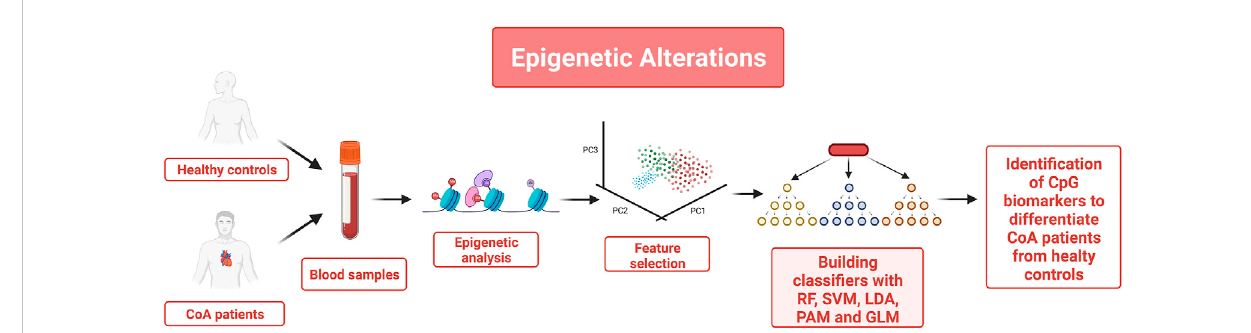
FIGURE 3 Blood samples were utilized to identify epigenetic changes that allow distinguishing healthy controls from patients with coarctation of the aorta (CoA).Cytosinenucleotide(CpG)methylationchangesobtainedfromGenome-wideDNAmethylationanalysiswereselectedasmeanfeatures.Onlythe probes with statistically signi fi cant methylation differences combined with a suf fi ciently high methylation fold change were kept as features and Multivariate approaches such as principal component analysis (PCA) and partial least squares-discriminant analysis (PLS-DA) were used to con fi rm that these featurescouldaccuratelydistinguishtheCoA samplesfrom thecontrols. 5classi fi ers werebuiltand trained usingthese features. Featureswith the highest predictive capabilities are potential novel biomarkers candidates for